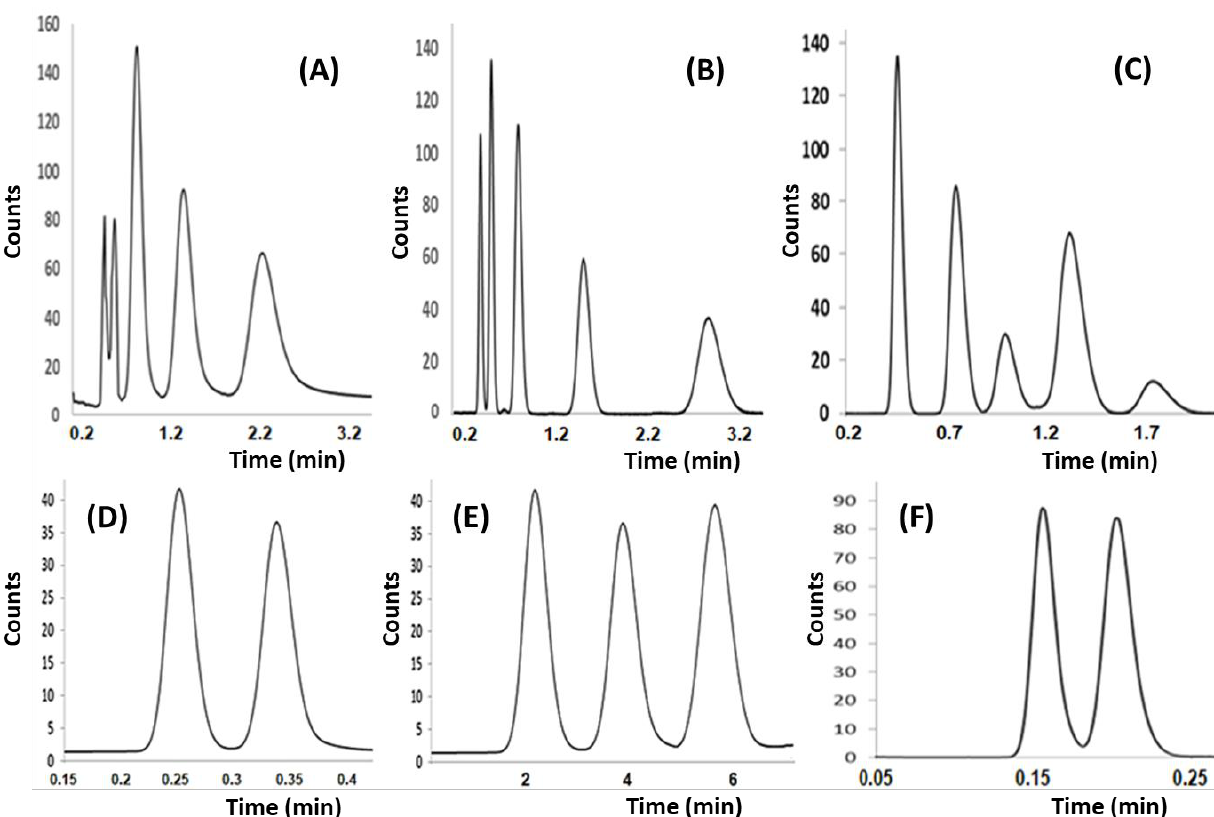
Figure 5. GC separation of the alcohol series under the optimal conditions using GMA ( A ) and MMT@poly(GMA-co-EDMA) ( B ). Conditions: flow rate: 0.5 mL min −1 , injector temperature: 250 °C,